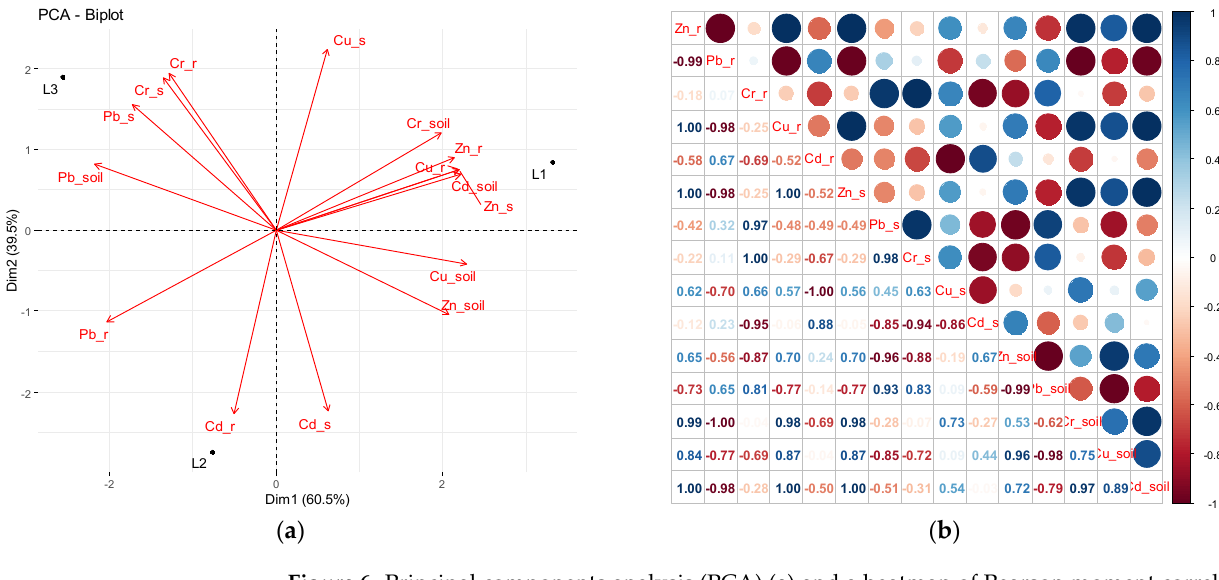
Figure 6. Principal components analysis (PCA) ( a ) and a heatmap of Pearson moment correlation coefficients ( b ) for heavy metal (Zn, Pb, Cr, Cu, and Cd) content in the root (r) and stem (s) of wheat in phenophase of full maturity in different localities (L1—Locality 1; L2—Locality 2; and L3—Locality 3).